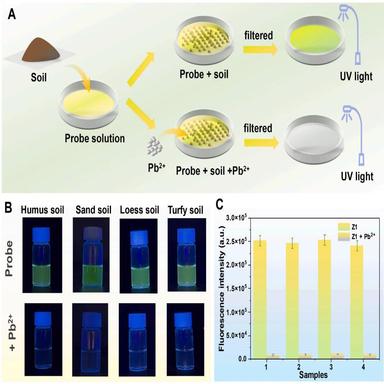
Schematic diagram of the soil analysis of Z1 for detection Pb2+. A. Schematic diagram of preparation of Z1 for detecting exogenous Pb2+ in soils. B. Images of the filtrates of different soils containing Z1 under UV–vis lamp (365 nm). (c) Fluorescence intensity ratio of soil filtrate.